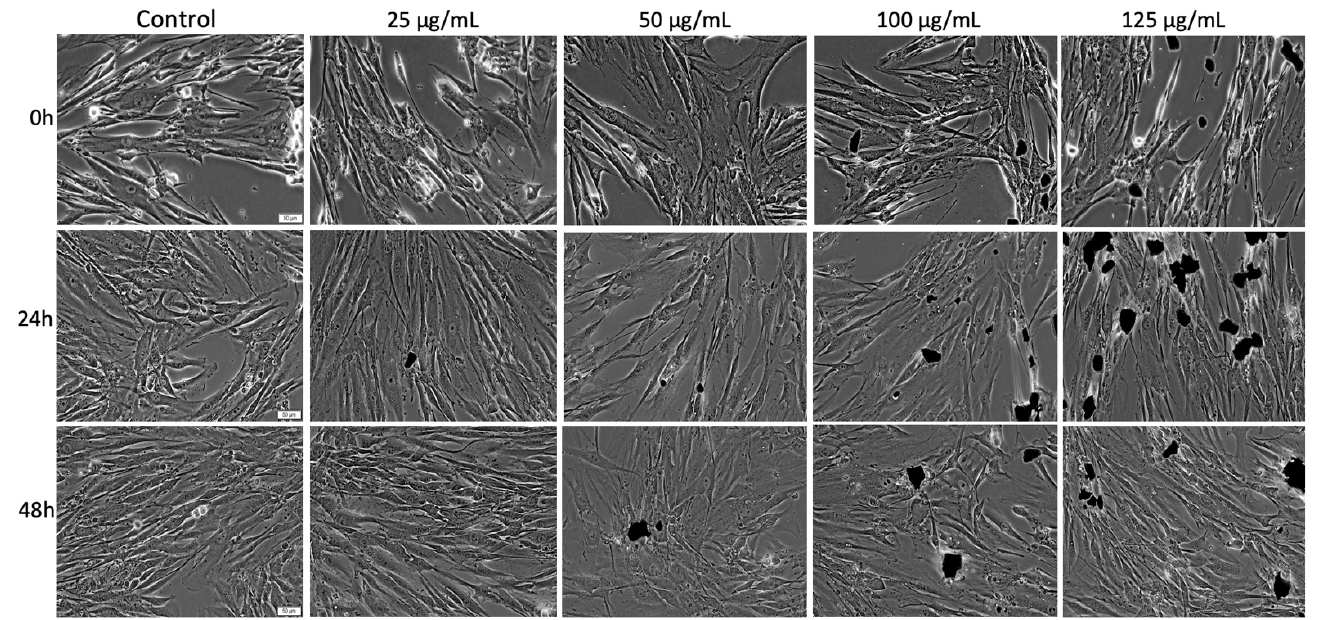
Figure 6. Morphological aspects of the primary human gingival fibroblast (HGF) monolayer—initially (0 h) and at 24 h and 48 h post-exposure to the Fe 3 O 4 @Carbon sample at different concentrations (25 µg/mL, 50 µg/mL, 100 µg/mL, 125 µg/mL). Pictures were taken at a magnification of 20×; the scale bars represent 50 µm. The black particles observed in the images represent the Fe 3 O 4 @Carbon sample.